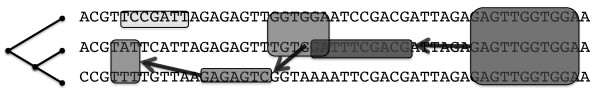
Schematic figure of DivE's heuristic approach. For each type of selection, and each node in the phylogenetic tree, first we identify local regions (denoted by shadowed rectangles in the figure) that score positively according to a log ratio selection score - the more intense the shadow color, the higher the score of that region is. Then DivE predicts as "under selection" the maximal scoring non-overlapping regions. The arrows in the figure connect predicted regions in the alignment.